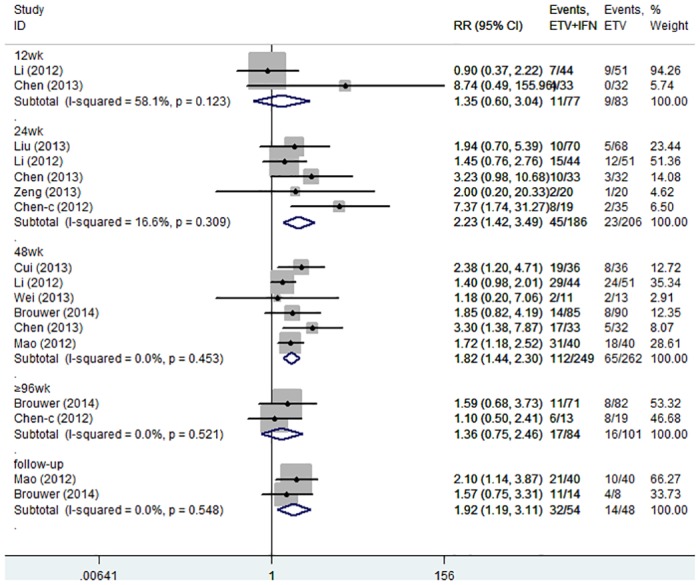
Forest Plot for HBeAg Seroconversion when ETV was used as the Control Group.